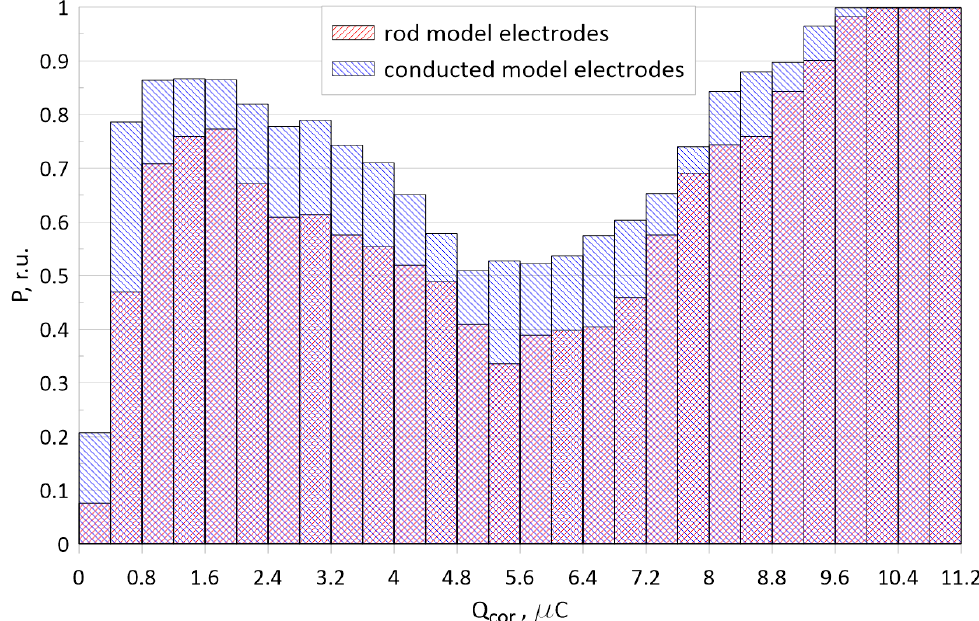
Figure 6. Dependence of the probability of a successful streamer–leader transition (P) on the mag- nitude of the charge flowing through the base of a pulsed streamer corona flash Q cor (1—rod model electrodes; 2—elongated model electrodes).